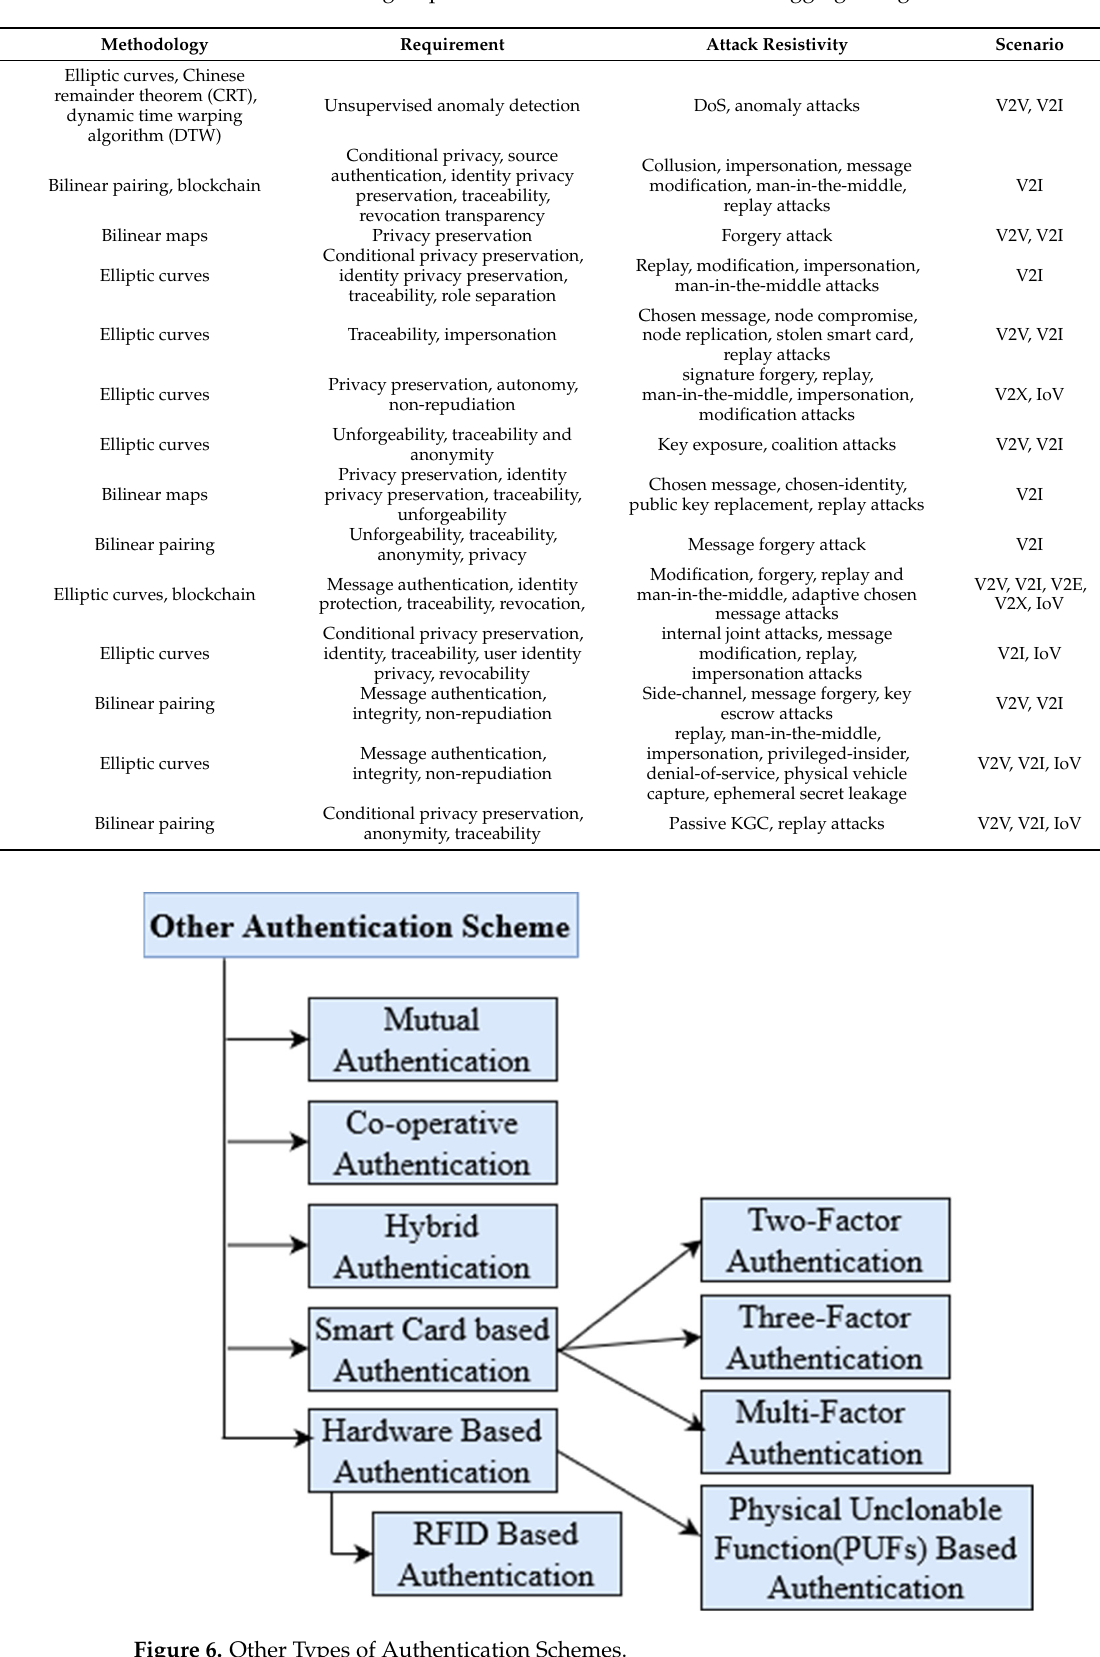
Table 4. Classification of group-verification-based certificate-less aggregate signature schemes.